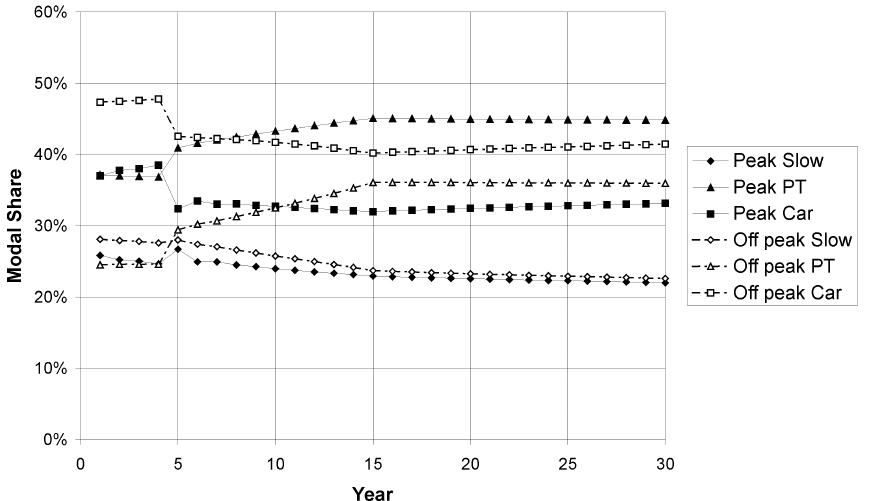
Figure 9: Mode split development Vienna SPM optimisation